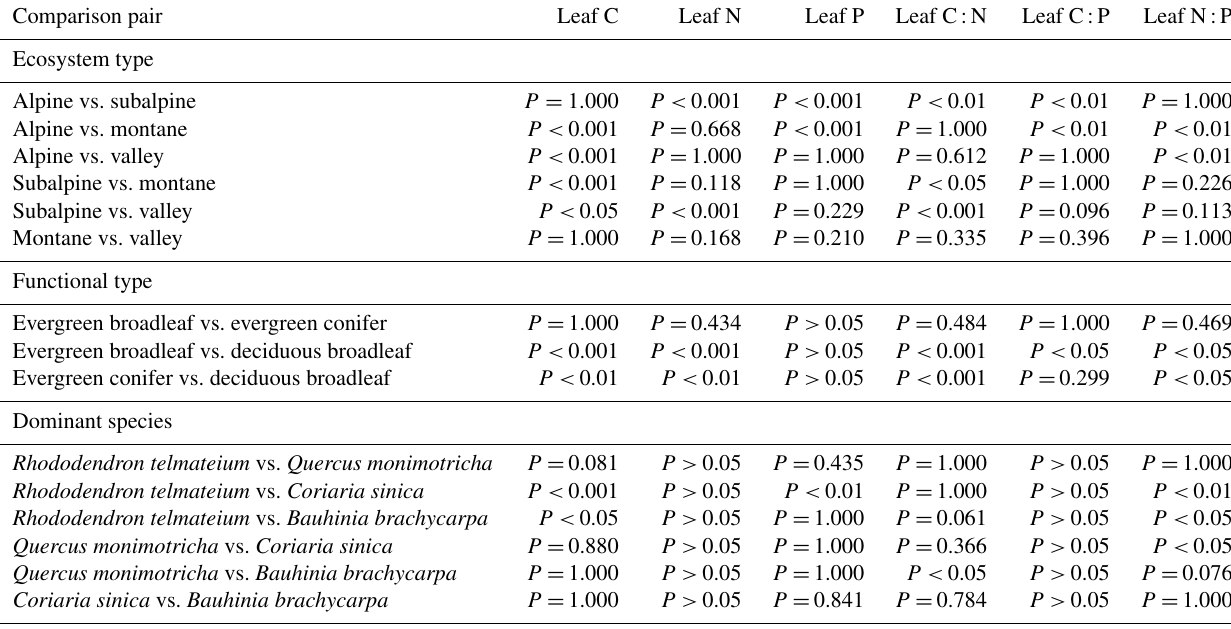
Table A2. Comparisons of geometric means of leaf stoichiometry using the Kruskal–Wallis test followed by pairwise comparisons. Comparison